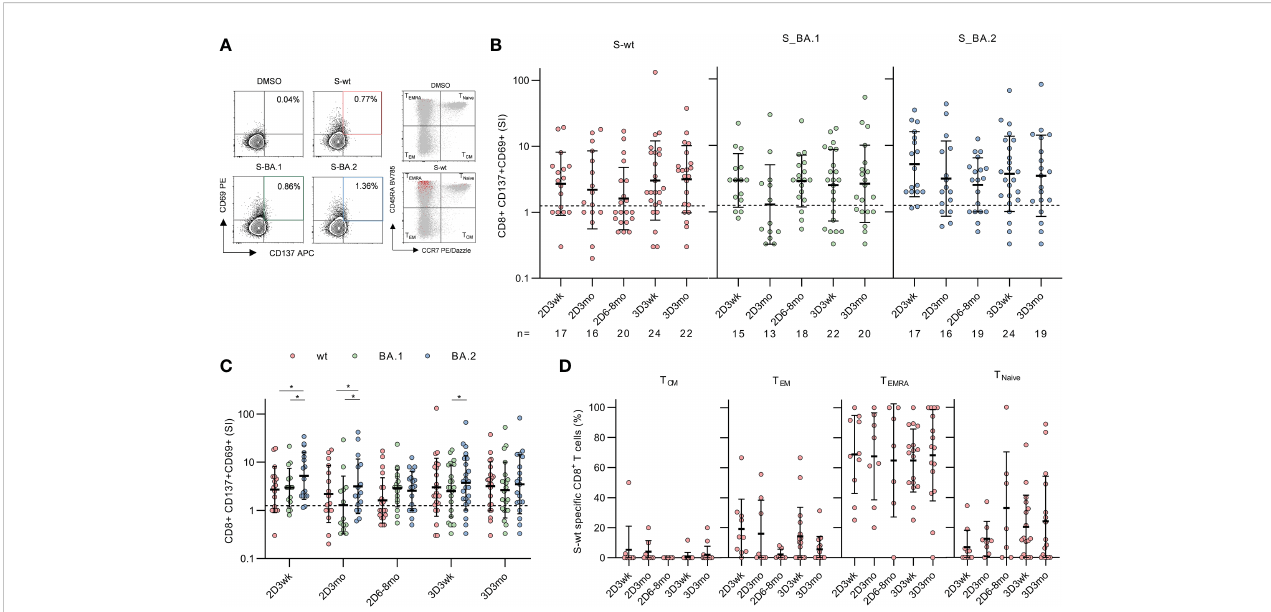
FIGURE 4 CD8 + T cell responses to SARS-CoV-2 wild type and Omicron BA.1 and BA.2 spike after the second and third mRNA vaccine dose. (A) , Representative fl ow cytometry plots and gating of CD8 + CD69 + CD137 + T cells and memory phenotypes of total CD8 + (gray) and activated CD8 + CD69 + CD137 + (red) T cells after stimulation with DMSO and SARS-CoV-2 (wt, BA.1, and BA.2) spike peptide pools. The gating strategy of CD8 + T cells is shown in Supplementary Figure 3. (B) , Spike-speci fi c CD8 + T cell responses in 32 vaccinated HCWs three weeks (2D3wk), three months (2D3mo), and six to eight months (2D6 – 8mo) after two vaccine doses, and three weeks (3D3wk) and three months (3D3mo) post the third vaccine dose represented longitudinally. The dotted line indicates the cut-off SI and the numbers below represent the sample size. (C) , Cross-comparison of CD8 + T cell responses after stimulation with wild type and Omicron BA.1 and BA.2 spike peptide pools. (D) , Distribution of S-wt-speci fi c CD8 + T cells expressing CD69 + CD137 + into memory subsets after the second and the third vaccine dose. Responses are shown only for samples with spike-speci fi c CD8+ T cell response >1 SI. Total CD8 + T cell responses and distribution are shown in Supplementary Figure 5. Error bars in (B-C) represent the geometric means with geometric SDs, and in d the means with SDs. In b and d, the statistical signi fi cance was determined with the Kruskal-Wallis test followed by Dunn ’ s multiple comparisons test since some participants were missing samples from individual time points. In (C) , the statistical signi fi cance was determined with Wilcoxon signed-rank test for paired samples: *p<0.05. CM, central memory; EM, effector memory; TEMRA, T effector memory CD45RA +